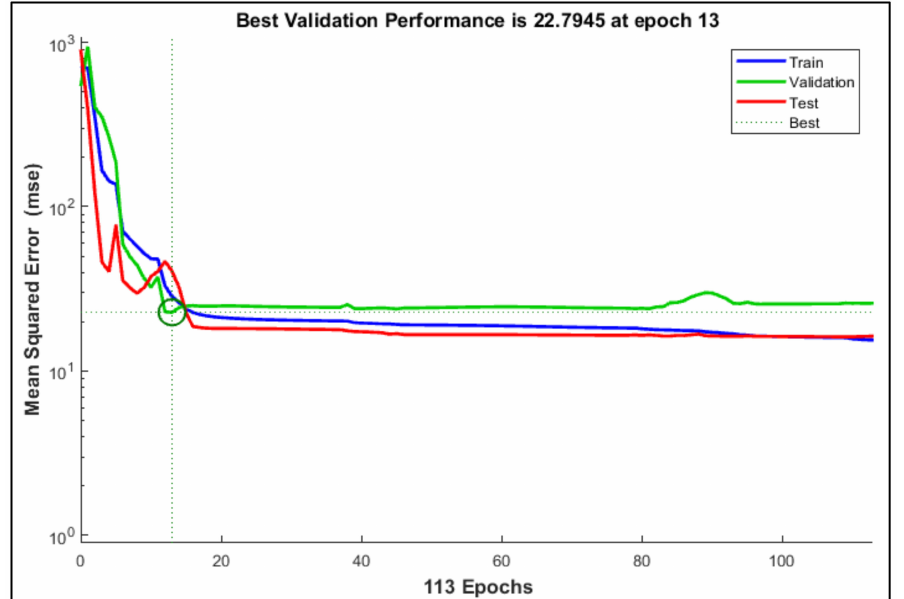
Figure 15. The MSE plot with respect to the